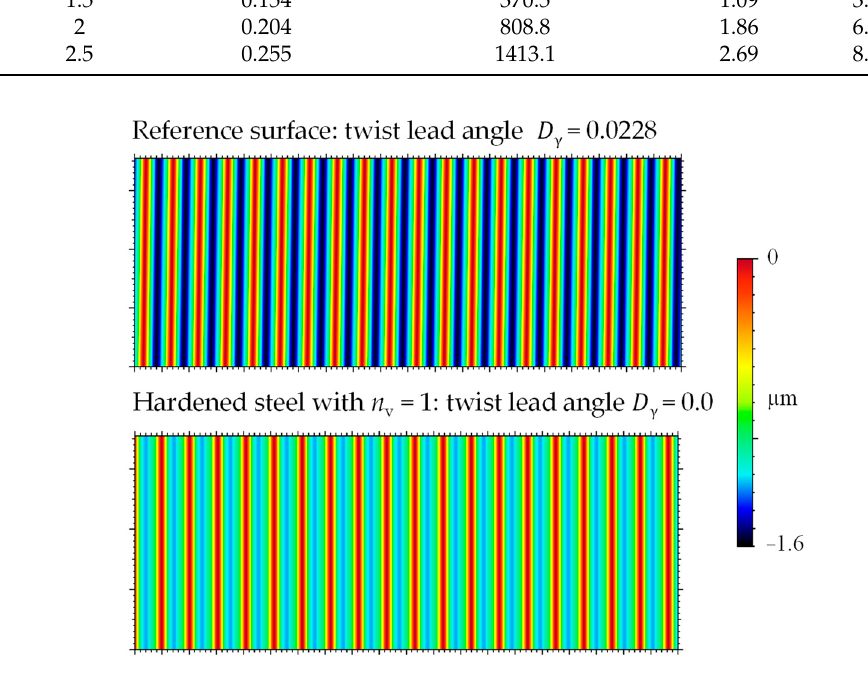
Figure 9. Optical comparison of the twist analyses according to MBN, taking the twist lead angle into account; each field is 2 mm in width and 36° in length. In the calculation of the surfaces by the algorithm according to MBN, the roughness edges are slightly rounded and therefore they are not included in the calculation of the twist parameters, such as the conveying cross-section DF MBN . In contrast, the